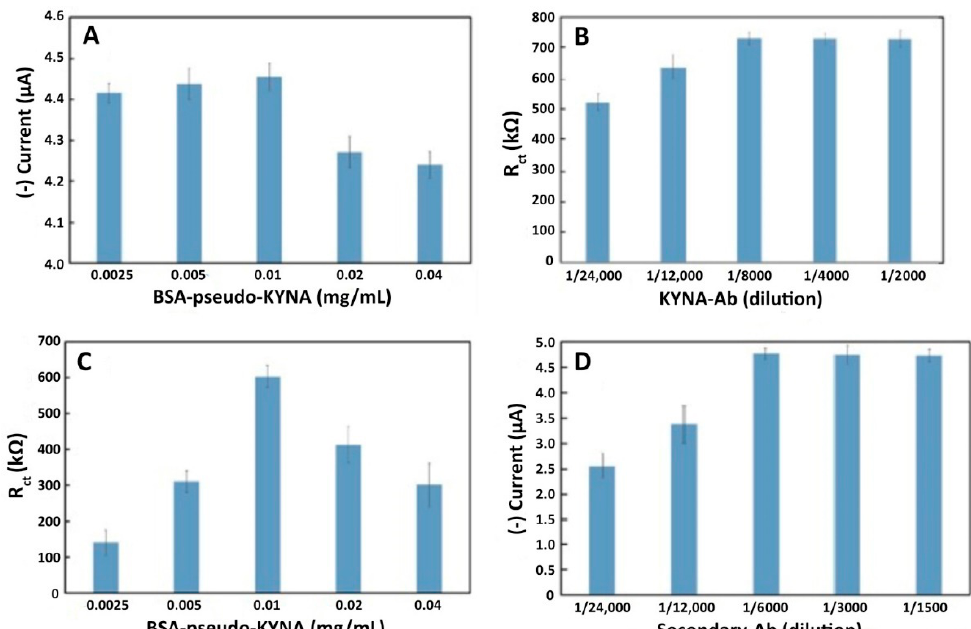
Figure 2. Chronoamperometry (CA) and EIS characterization of the optimization of the biosensor’s different layers. ( A , B ) BSA-pseudo-KYNA concentration optimization for sensor functionalization, characterized by CA and EIS, respectively; ( C ) KYNA-Ab concentration optimization using EIS in the characterization; ( D ) secondary-Ab concentration optimization characterized with CA.